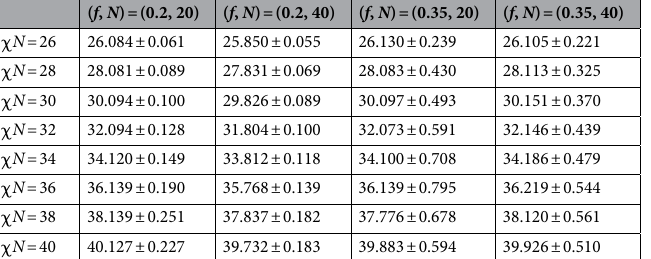
Table 4. Averages and standard deviations of estimated χ N for each χ N class, which is the same for the teaching